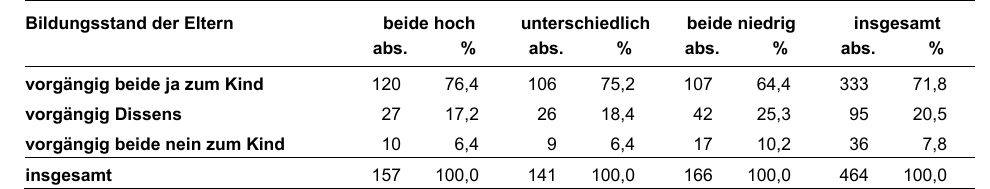
Tabelle 4 : Bildung und vorgängige KW-Konstellation der Paare bei Geburt eines Kindes (alle 4